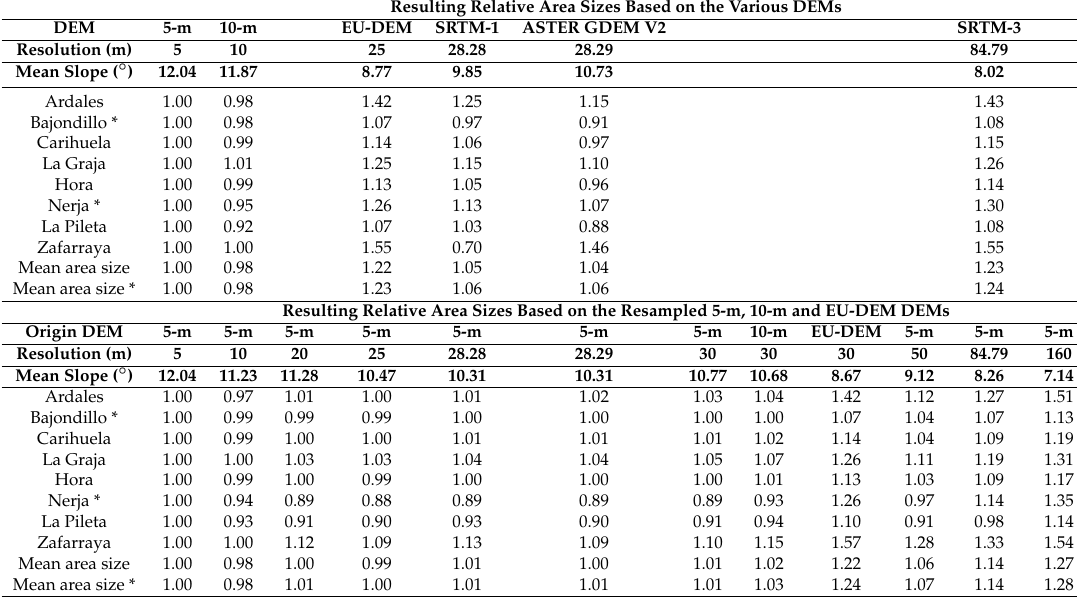
Table 8. Resulting relative area sizes of 4-h site catchments calculated with the presented method. The results of the 5-m DEM are the reference with a size index of 1. The method was applied to 8 prehistoric sites with the various DEMs and with resampled versions of the 5-m DEM and 30-m resamples of the EU-DEM and the 10-m DEM as input data, to allow comparison at similar horizontal resolution. * = sites are located near the coast and excluded from the calculation of the mean area